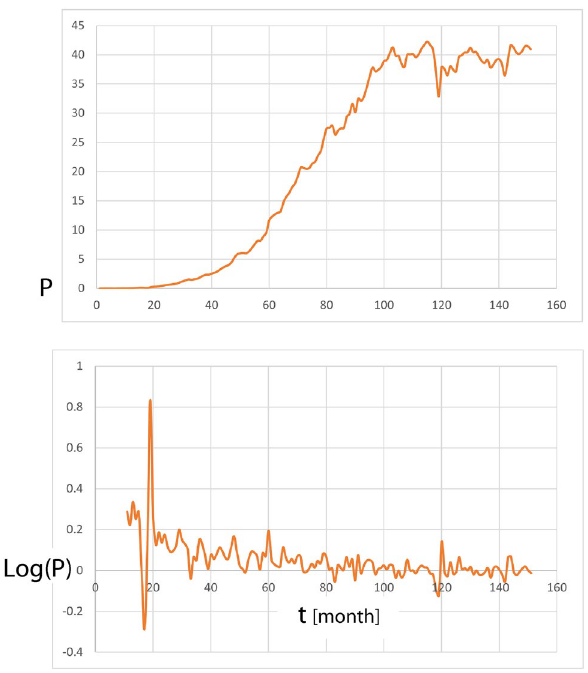
Figure 4. Evolution of Android’s market percentage P, top panel, and corresponding logarithmic changes Log(P), bottom panel, from January 2009 to July 2021 (monthly data).